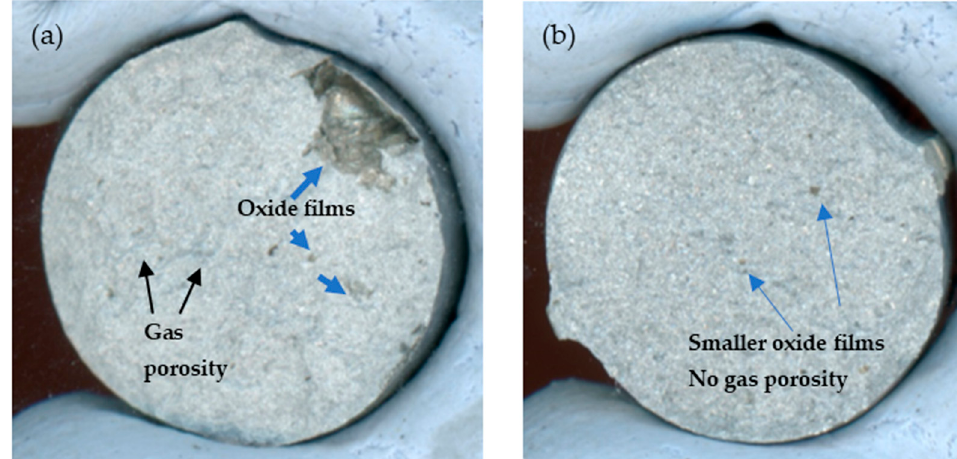
Figure 8. Fracture surfaces of postmortem tensile bars that were cast after ( a ) conventional rotary degassing and ( b ) HSMC degassing. Representative samples are from a previous study [24].